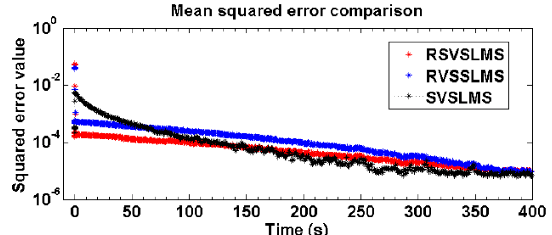
Figure 18. Bar chart showing a plot of the output signal power for the different LMS techniques and the SNR of the main signal. The signal to noise ratios for the three datasets are 55.5 dB, 61.5 dB and 69.4 dB for data 1, 2 and 3, respectively. The RSVSLMS technique returns the retrieved signals with the highest power, and its followed closely by those obtained from the RVSSLMS technique.